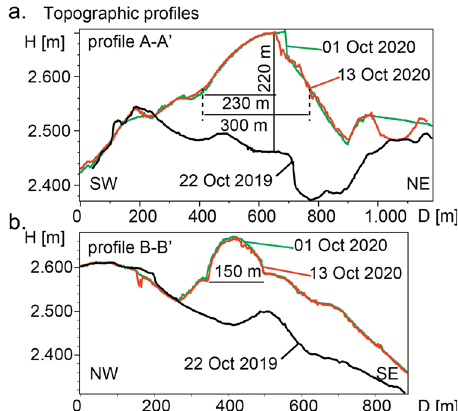
Fig. 5 Temporal evolution and dimension. Topographic pro fi les through the DTM data in a . SW-NE direction (pro fi le A-A ’ ) and b in NW-SE direction (pro fi le B-B ’ ) reveal the spine height is 220m above the pre- existing topography, where a large amount of the elevation change is due to dome formation and talus materials. Note that the vertical cliff of the spine co-locates with the buried cliff of the 2019 collapse scar. Data highlights major topographic complexity prior to dome and spine growth, but also contains local data artifacts, e.g., at the NE part of pro fi le A-A ’